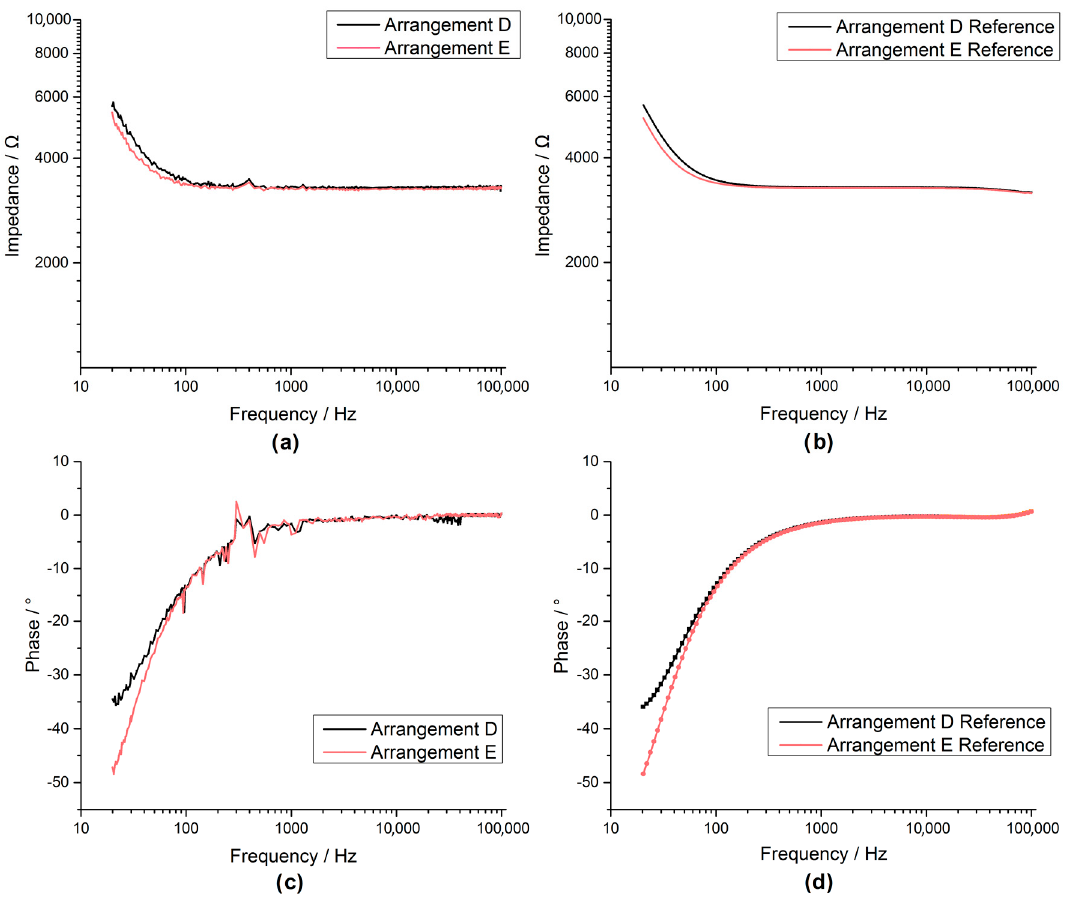
Figure 23. The Bode plot for the arrangements D, E recorded with the AD5933 custom system are shown in figures ( a , c ), while the bode plots for the same arrangements recorded by an Autolab PGSTAT302N impedance module are shown in figures ( b , d ).